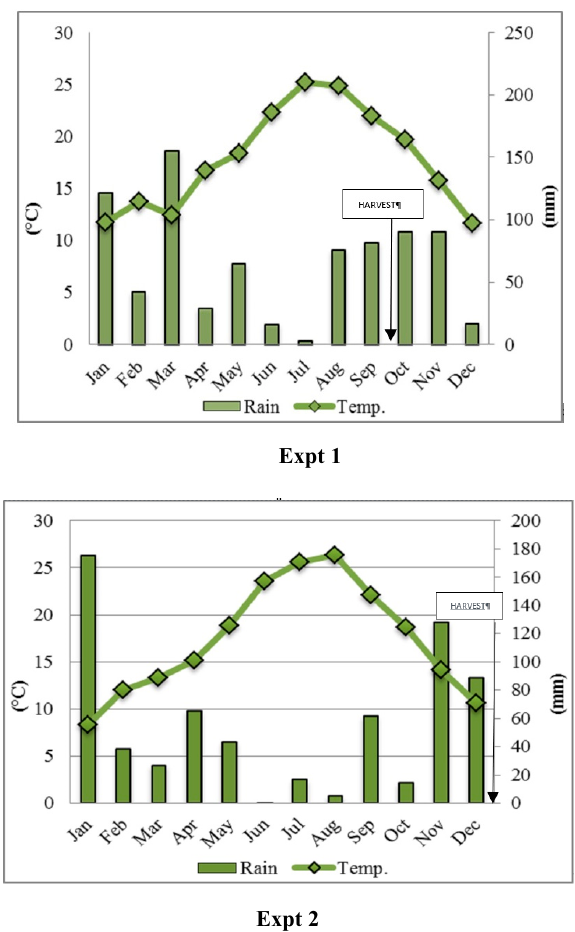
Figure 2. Mean monthly air temperature and monthly precipitation in the olive orchards where experiments were conducted in 2016 ( Expt. 1 ) and in 2017 ( Expt. 2 ). Table 1. Main physical and chemical characteristics of the olive orchard soils of first experiment at Lamezia Terme ( LT ) and the second experiment at Feroleto antico ( FA ).